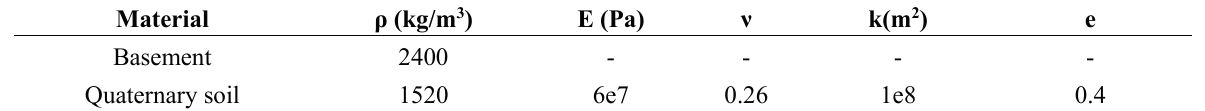
Table 3. Geotechnical parameters for the finite element model of Figure 2c Material ρ (kg/m 3 ) E (Pa) ν k(m 2 ) e Basement 2400 - - - -